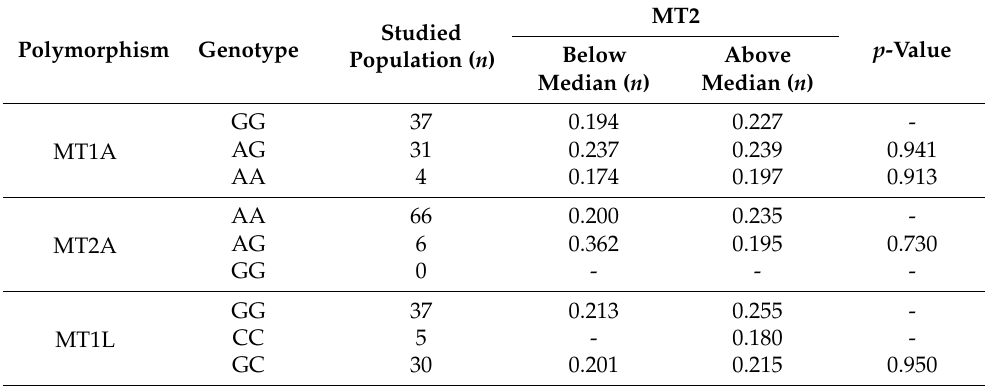
Table 2. Associations between specific MT polymorphisms and MT2 concentration.